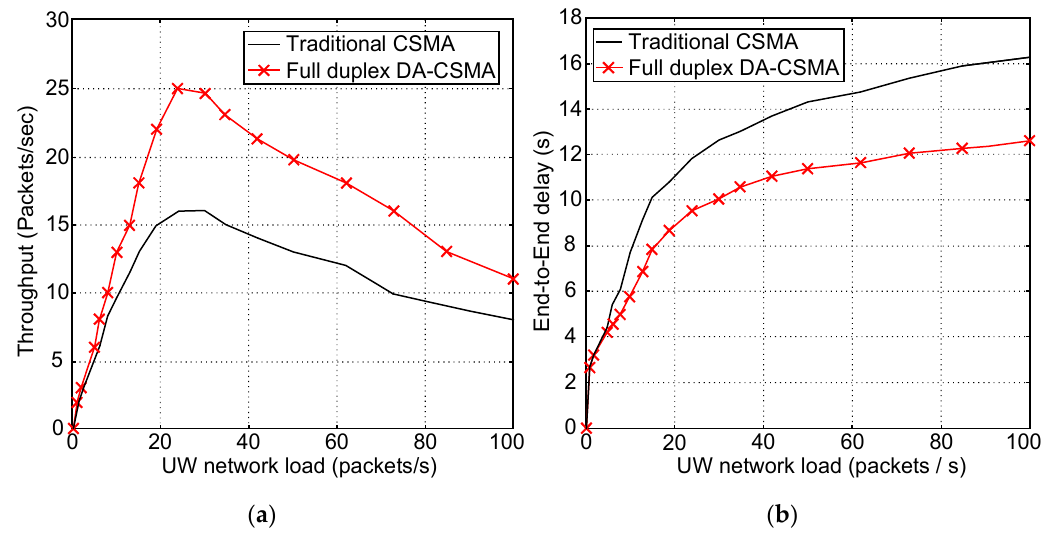
Figure 4. ( a ) Throughput and ( b ) end-to-end delay comparison of full-duplex DA-CSMA and traditional CSMA MAC protocols.